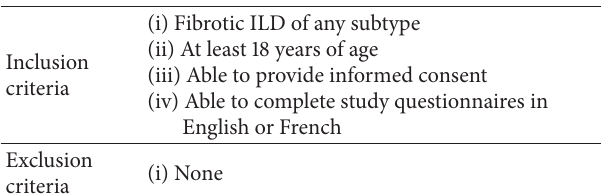
Table 1: Eligibility